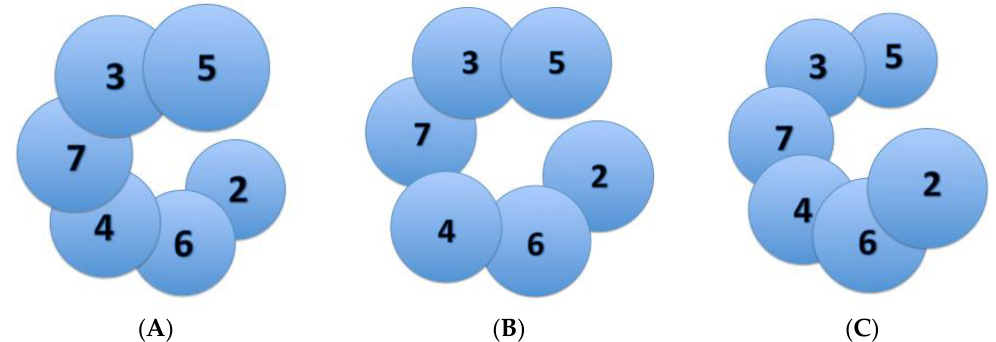
Figure 3. Viewing the Mcm2-7 ATPase domains from under the C-terminal domain. ( A ) a visual representation of the left-handed spiral configuration adopted by Mcm2-7 in its bare state [12,13]; ( B ) a visual representation of the Mcm2-7 hexamer in its relatively planar configuration while present as an inactive Mcm2-7 double hexamer [3,13]; ( C ) the observed right-handed configuration of Mcm2-7 in its active CMG, DNA-bound state [14].